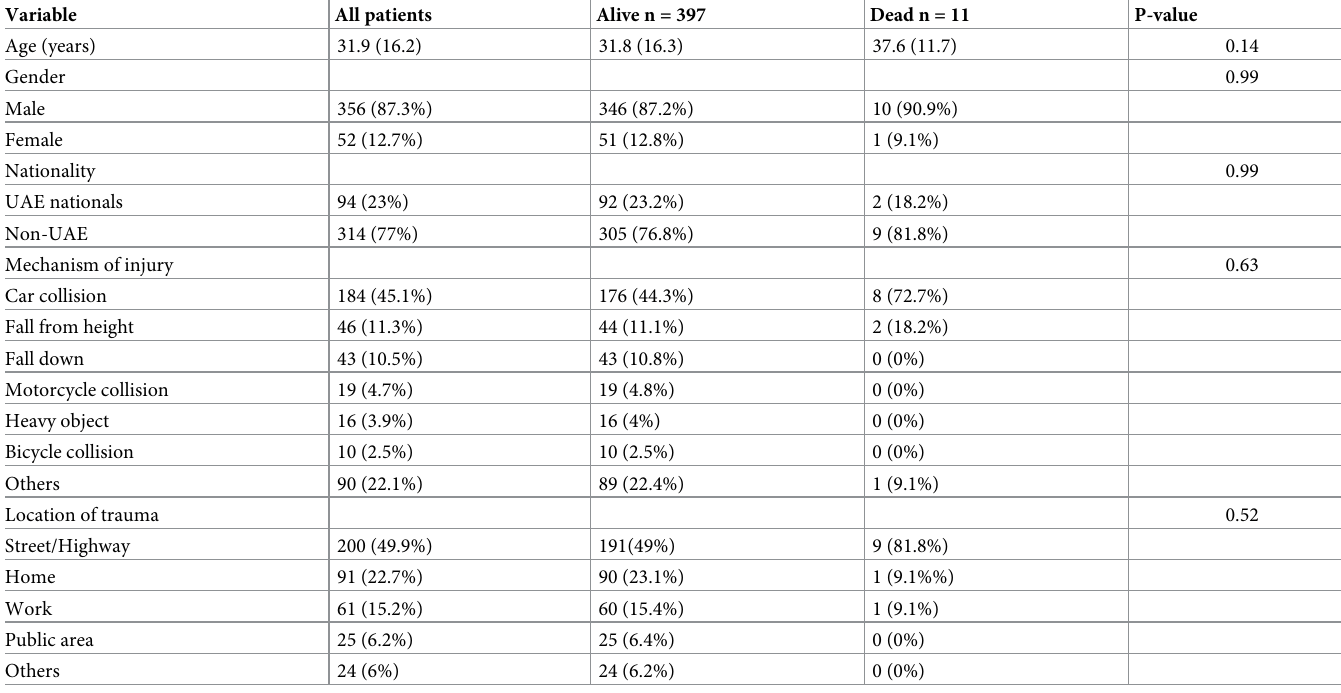
Table 1. Two-sample data analysis comparing the demography of hospitalized facial injury patients who died and those who survived during the period of 2014– 2017 at Al-Ain Hospital, Al-Ain City, United Arab